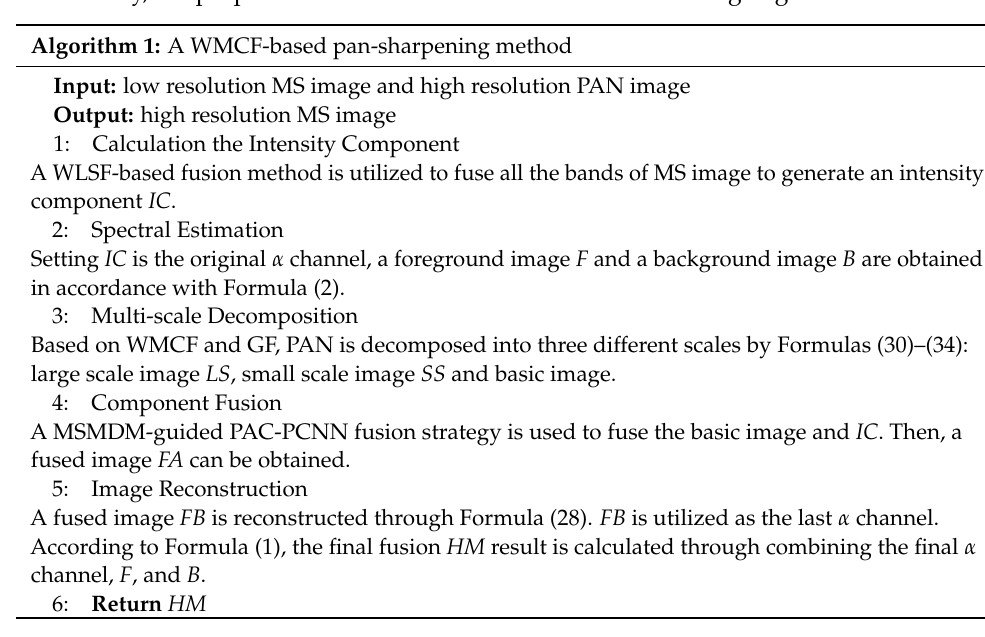
Algorithm 1: A WMCF-based pan-sharpening